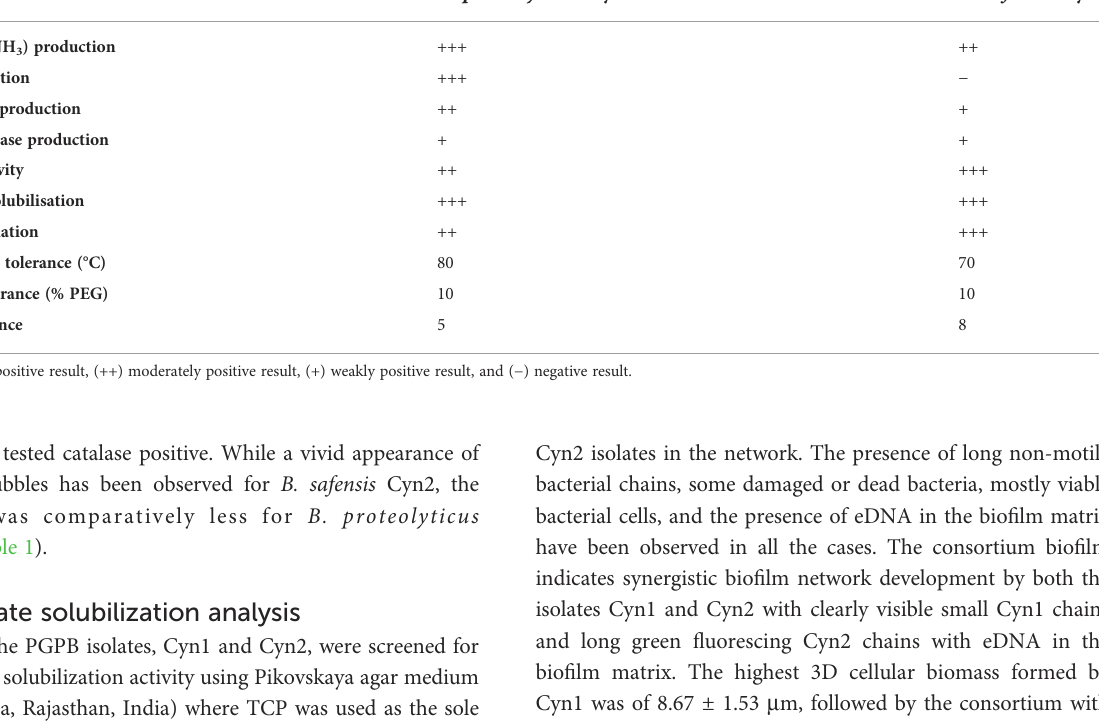
TABLE 1 Plant-growth-promoting (PGP) traits and abiotic stress tolerance of the bacteria isolated from root rhizosphere of P . vulgaris L. “ Sapito. ” . PGP